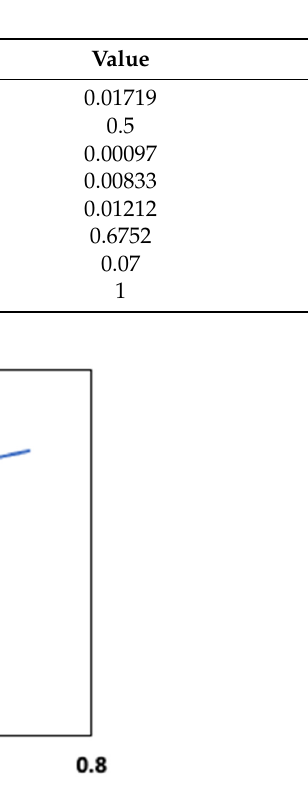
Table 1. Surimi gel properties and Johnson–Cook parameters.